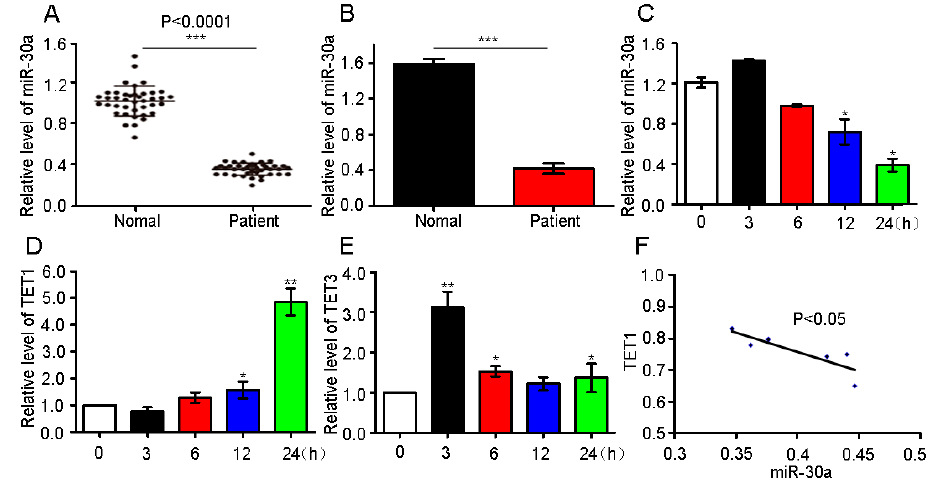
Figure 1. miR-30a expression in idiopathic pulmonary fibrosis (IPF) patient and analysis of the